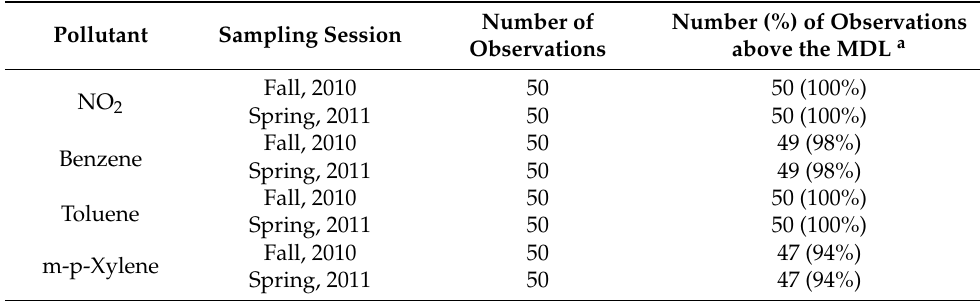
Table 1. Number of observations above minimum detection limits (MDLs) for NO 2 , benzene, toluene, and